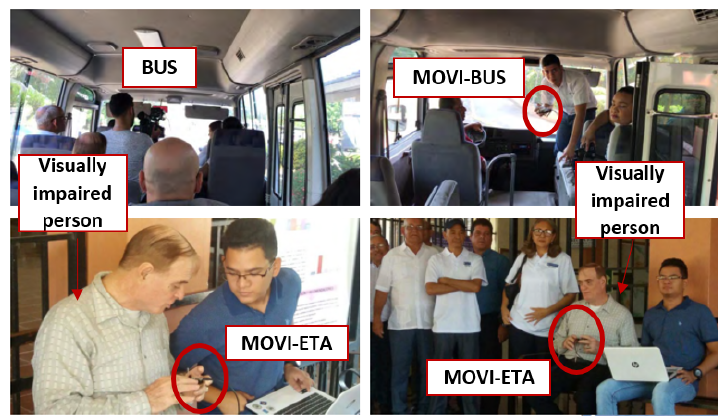
Figure 6. MOVIDIS system